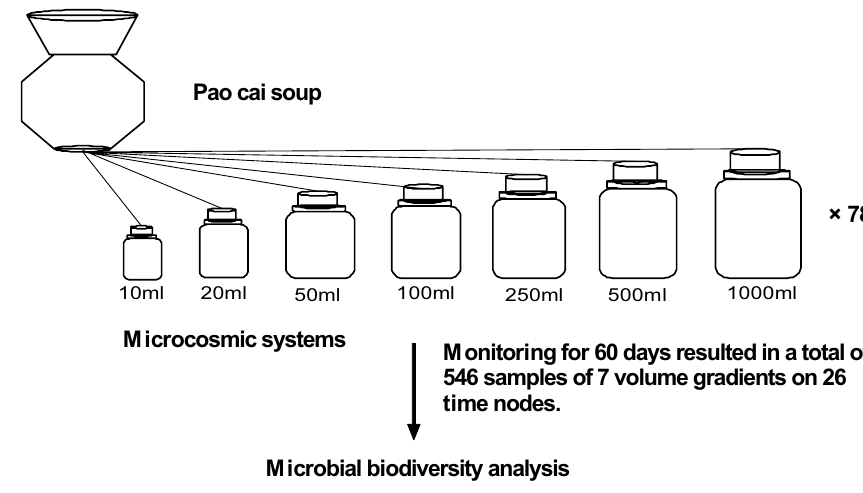
Figure 1. Schematic diagram of the establishment of the microcosmic